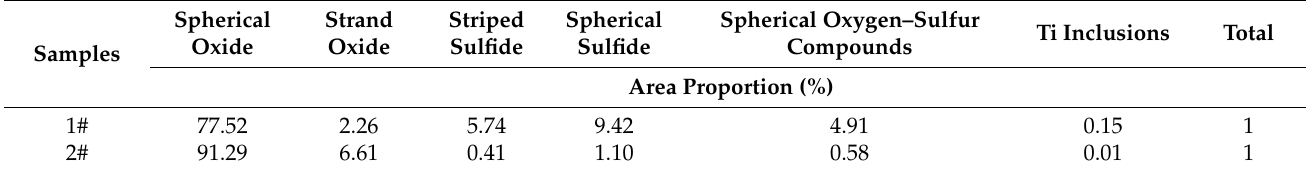
Table 6. The proportional area occupied by various inclusions in 100 mm 2 sections of steel samples.